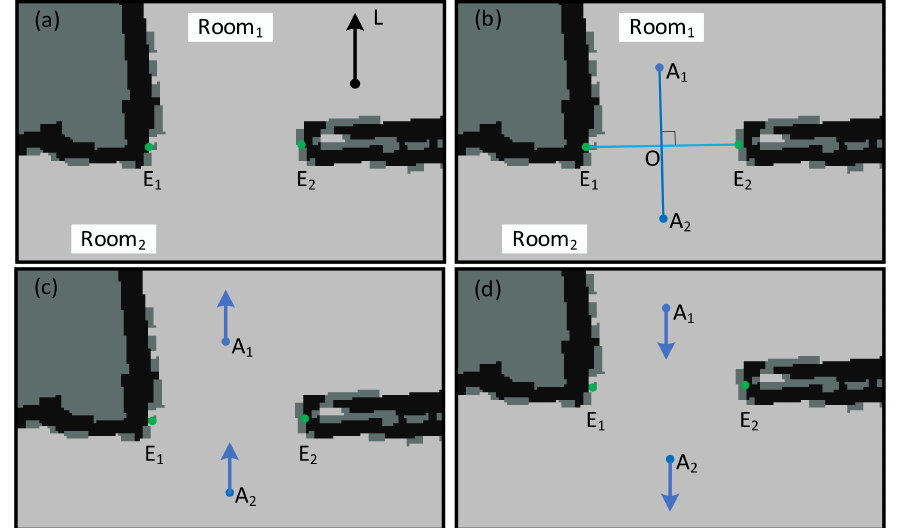
Figure 5. Auxiliary navigation points. ( a ) Coordinates of the door endpoint, E 1 and E 2 ; dominant directions of the room, L; room semantic information, Room 1 and Room 2 . ( b ) Perpendicular line A 1 A 2 . ( c ) Point and upward orientation. ( d ) Point and downward